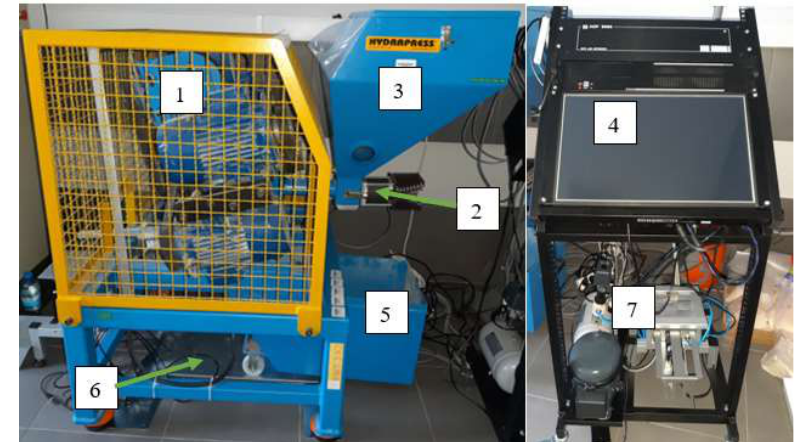
Figure 2. Test stand for the intelligent monitoring of granular mass characteristics: 1—five-disc grinder, 2—worm feeder, 3—hopper, 4—control unit, 5—reception basket of the product of grinding, 6—weight of the product of grinding, and 7—integrated system for the analysis of the grinding product’s particle size [28].